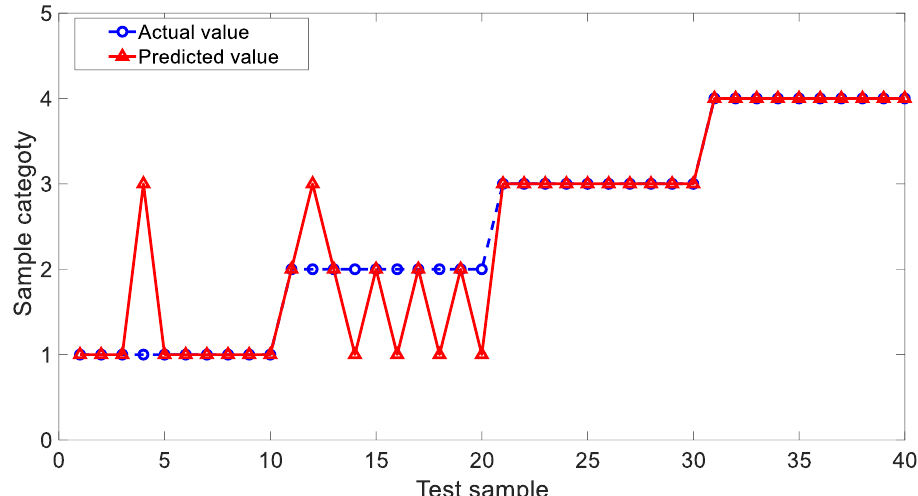
Figure 17. Comparison between the actual and predicted values by BP_NN.